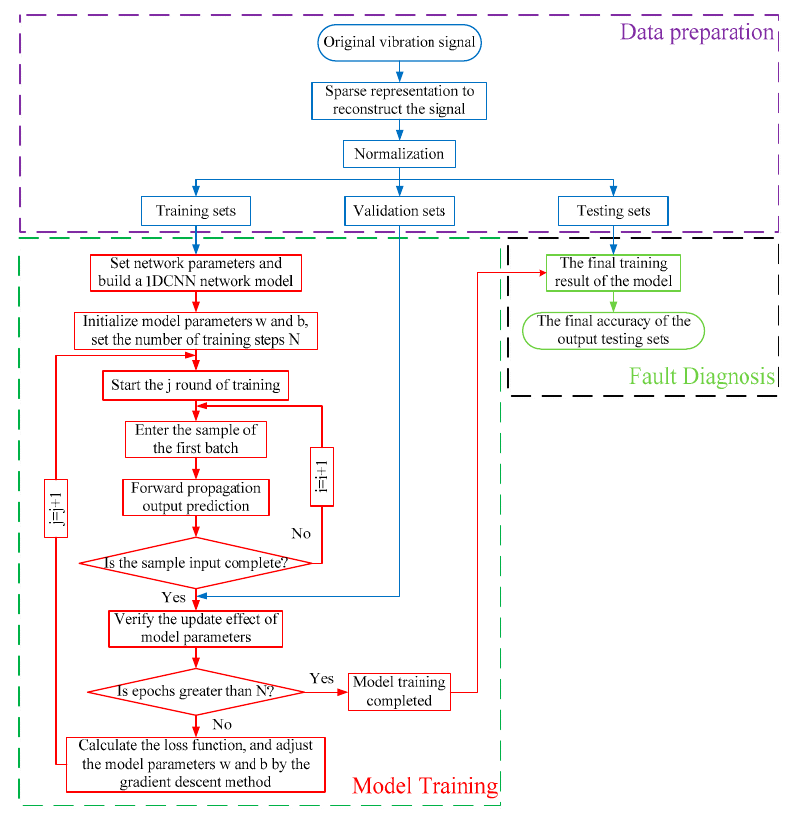
Figure 3. Fault diagnosis process based on adaptive learning dictionary and 1DCNN.